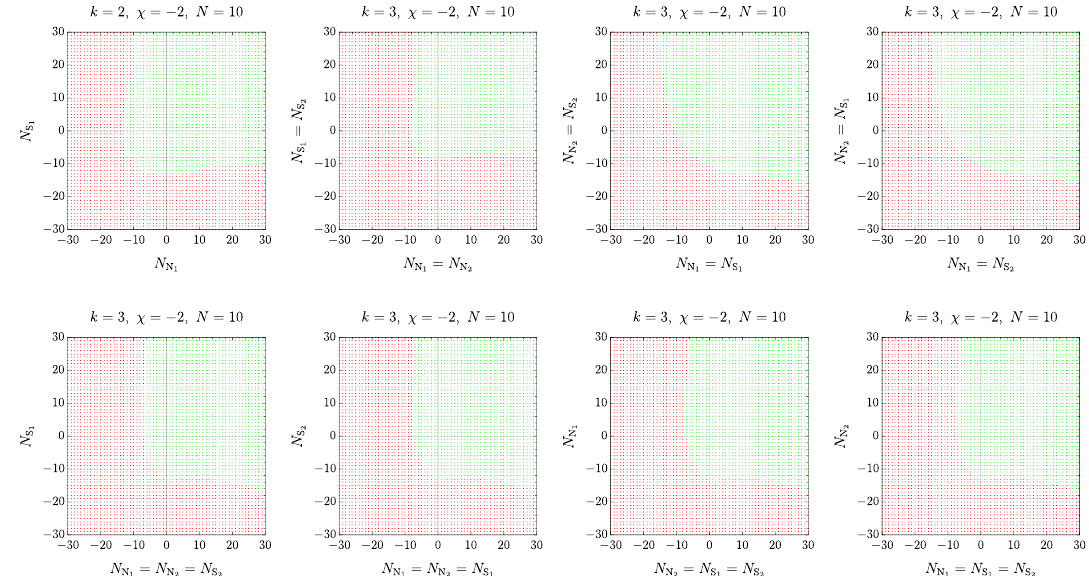
Figure 5. 2d exclusion plots visualizing the existence/nonexistence of the central charge a for k = 2 and k = 3 . The choices of k , χ , N are labeled on top of each plot, whereas the specific configuration of the (integral) flux quanta, N , N , can be read off from the coordinates of a given dot. A dot is N i S i green if a exists for the corresponding combination of flux quanta; it is red if a does not exist. Note that the upper four plots are symmetric with respect to the exchange of axes as a consequence of the D symmetry of M 2 4